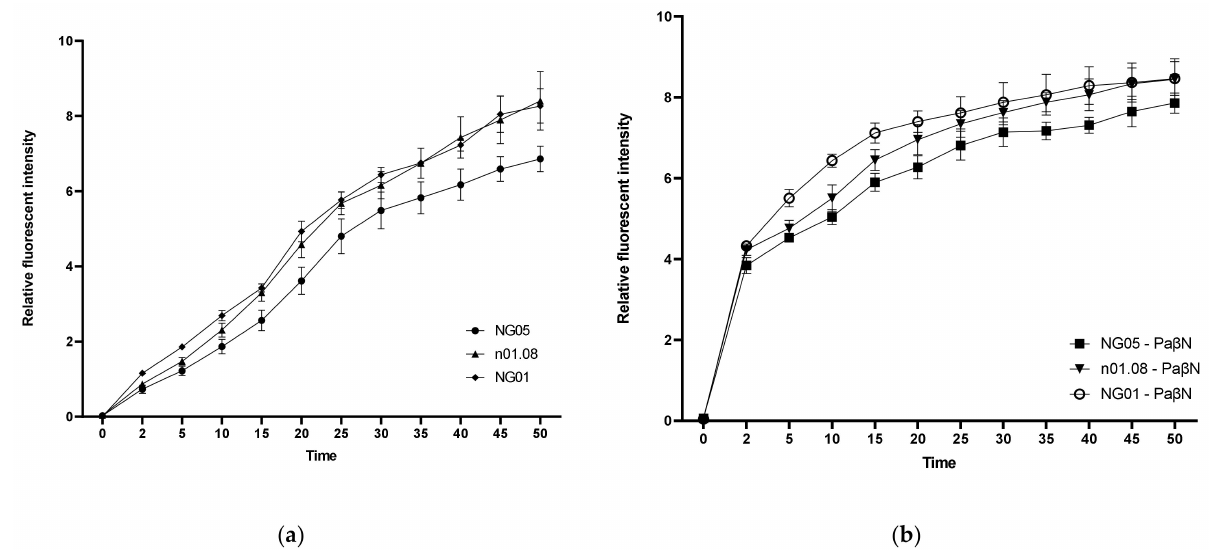
Figure 2. Fluorescence emission of ethidium bromide from N. gonorrhoeae strains. Efflux level of n01.08, NG01, and NG05 ( a ) and with the addition of Pa β N as an EPI ( b ). Data depict the mean and SD of at least 3 experiments. ANOVA analyses revealed significant differences ( p < 0.0136) for both n01.08 vs. NG05 and NG01 vs. NG05 in the time range between 35 and 45